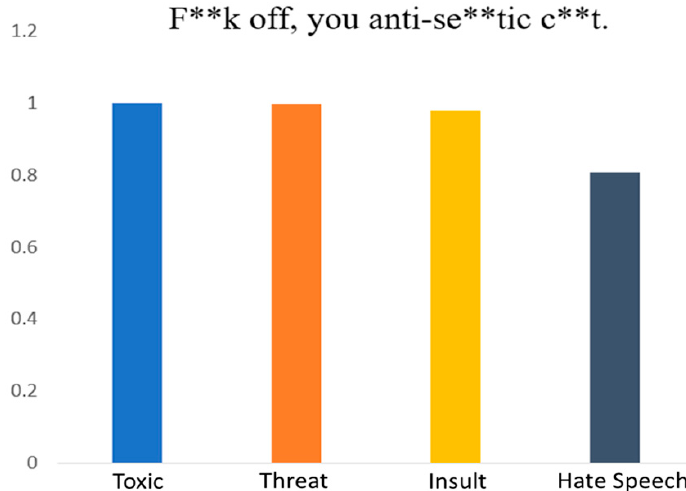
Figure 4. Probability of the presence of different types of toxic content.